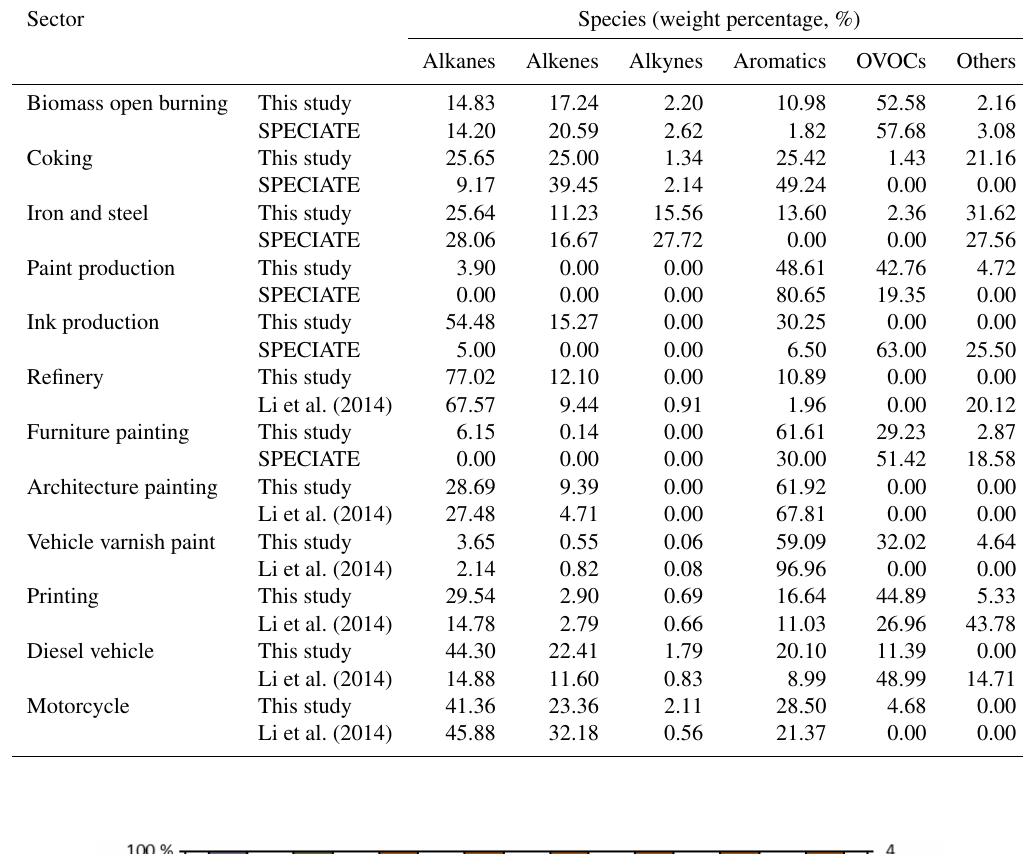
Table 4. Updated NMVOC source profiles in this study and those from SPECIATE and Li et al. (2014).